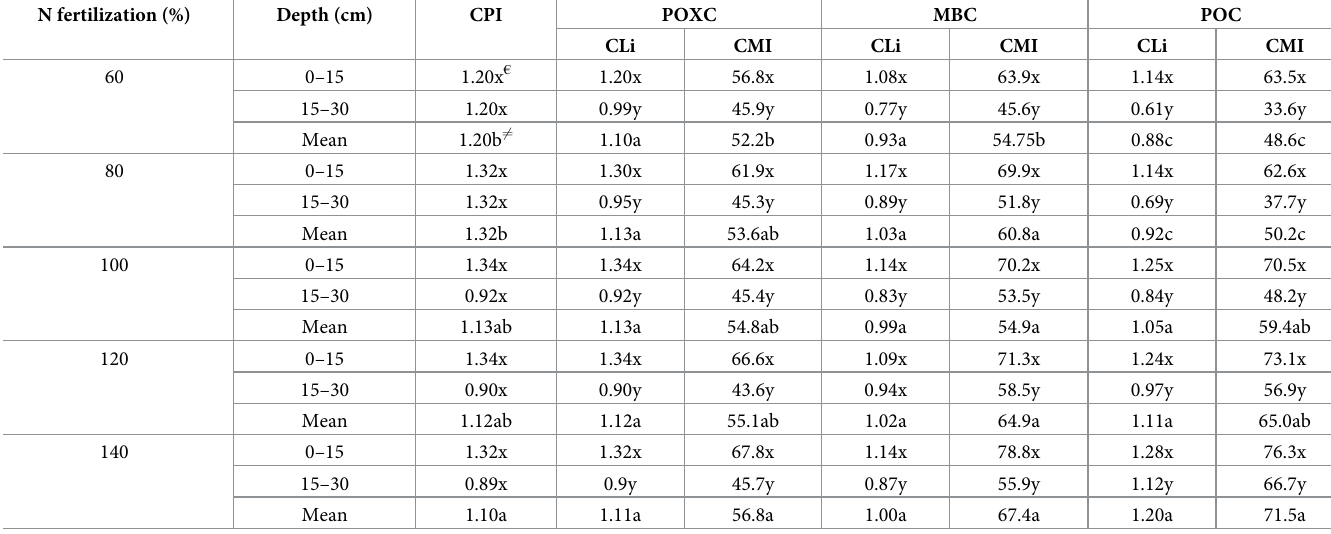
Table 5. Impact of nitrogen fertilization on soil depth distribution of carbon pool index, carbon liability index, and carbon management index. N fertilization (%)